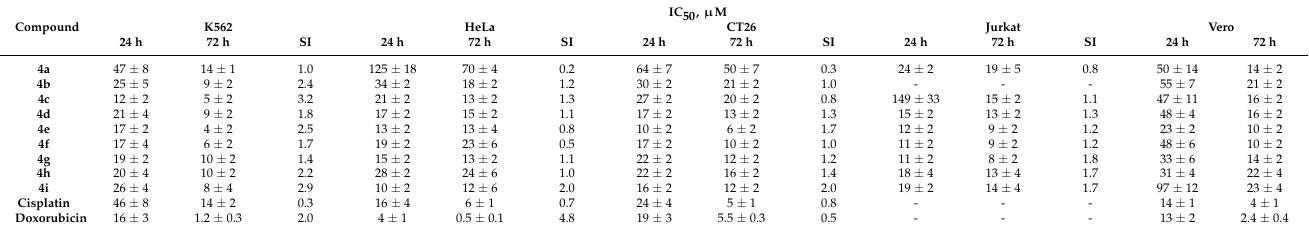
Table 1. IC 50 value for 3-azaspiro[bicyclo[3.1.0]hexane-2,5 (cid:48) -pyrimidines] 4b – i